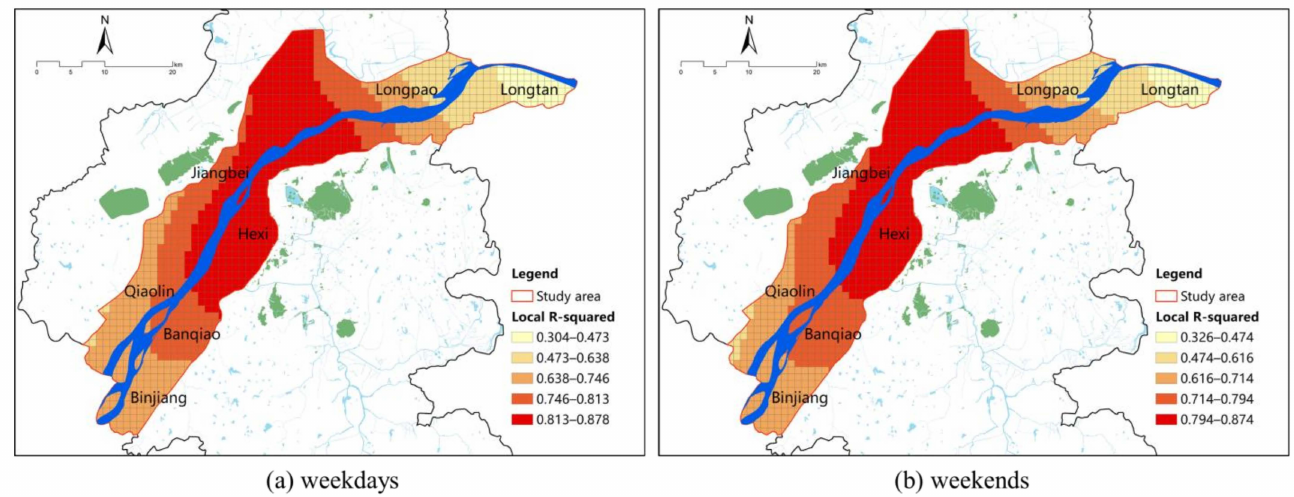
Figure 4. Spatial characteristics of local R-squared values with the GWR model: ( a ) local R-squared values on weekdays; ( b ) local R-squared values on